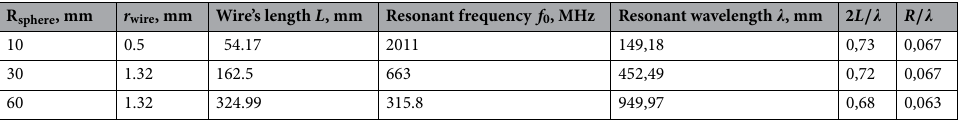
Table 1. Resonance tuning of a spherical helix scatterer.